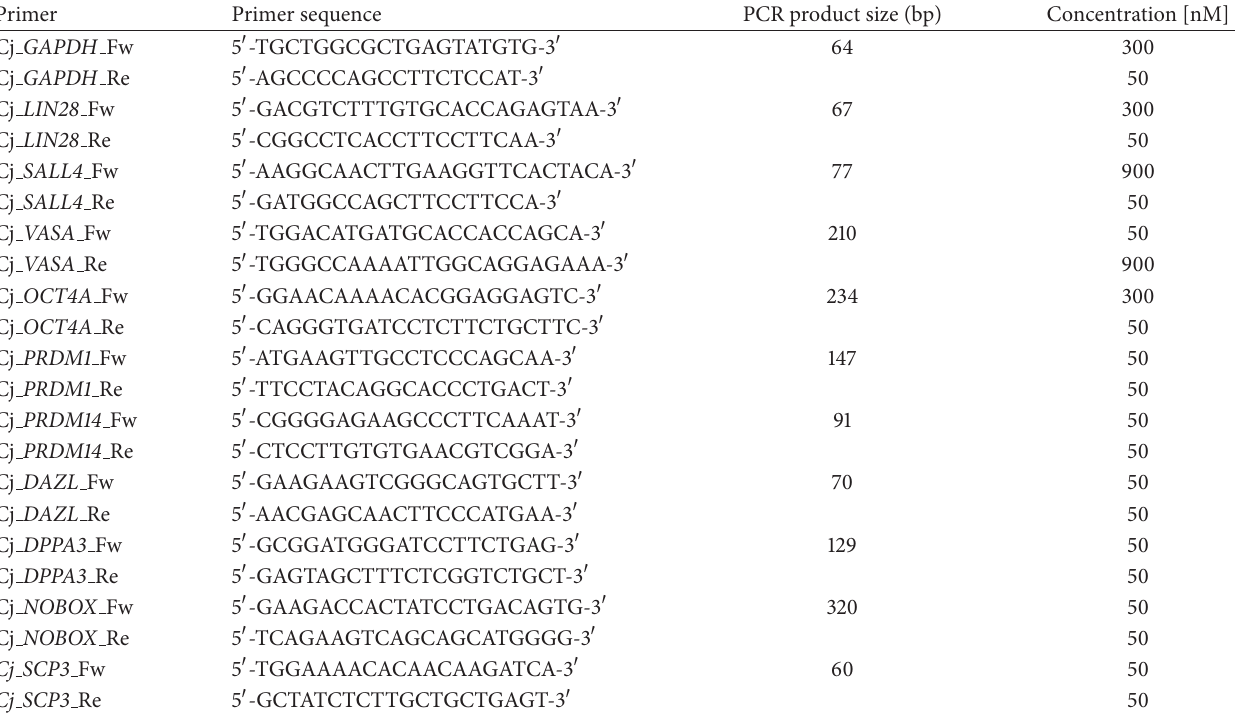
Table 1: Primer sequences, sizes of amplicons, and concentration of respective